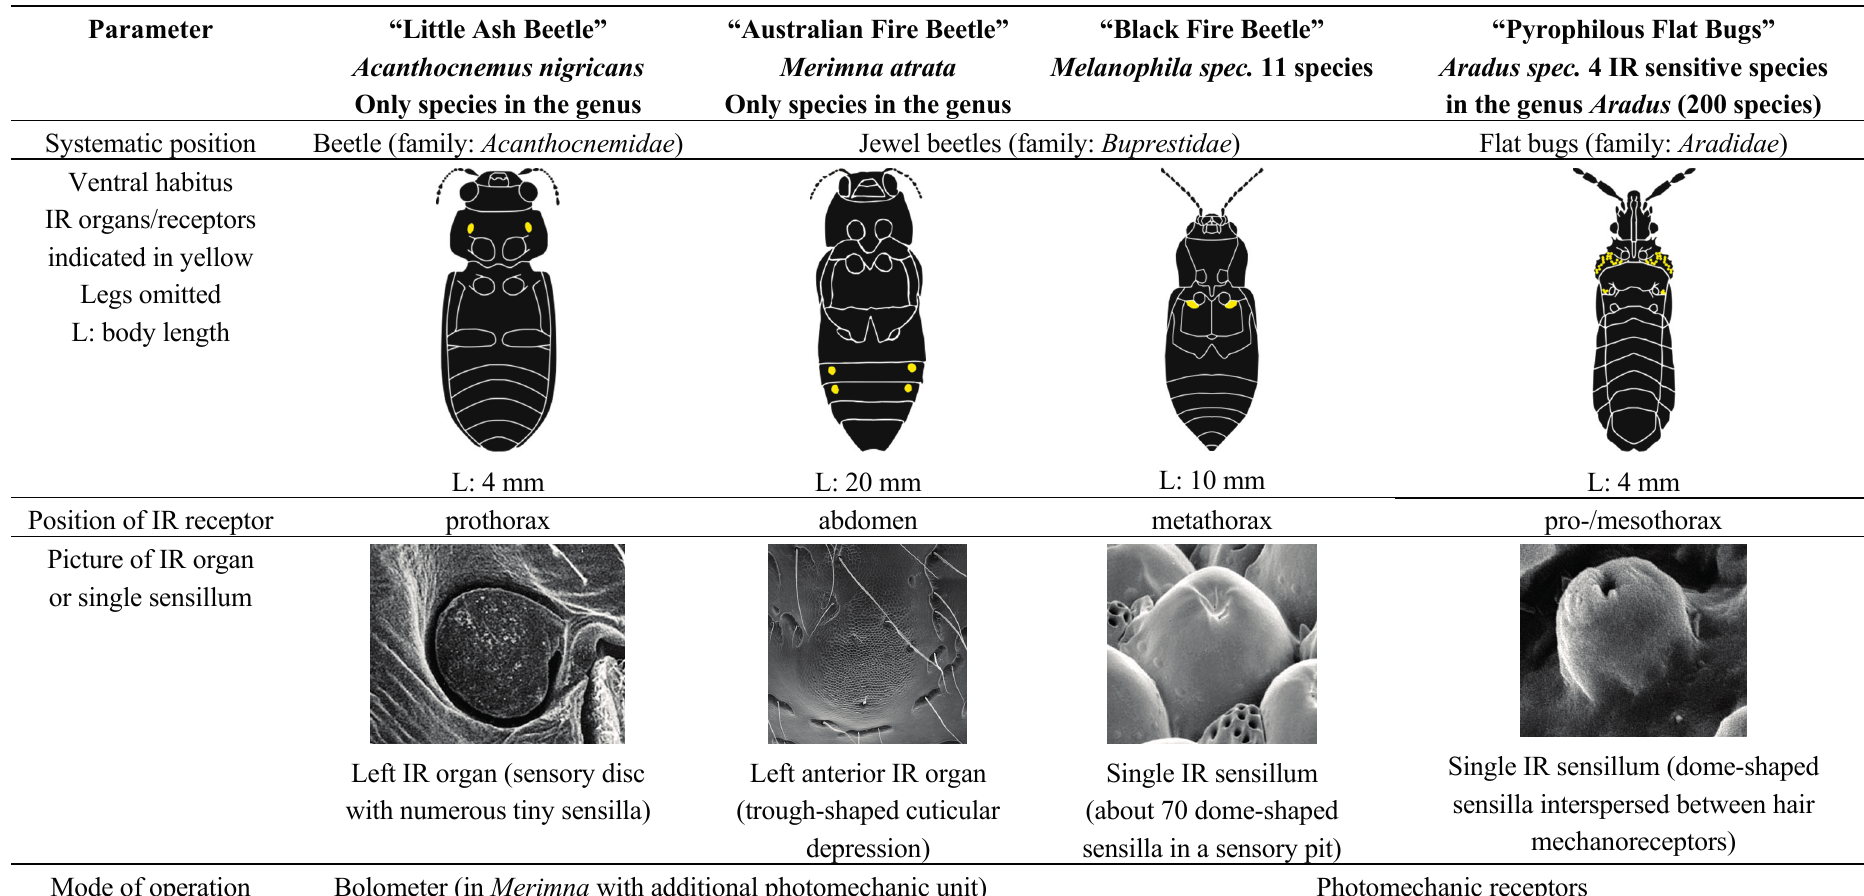
Table 1. Infrared receptors in pyrophilous